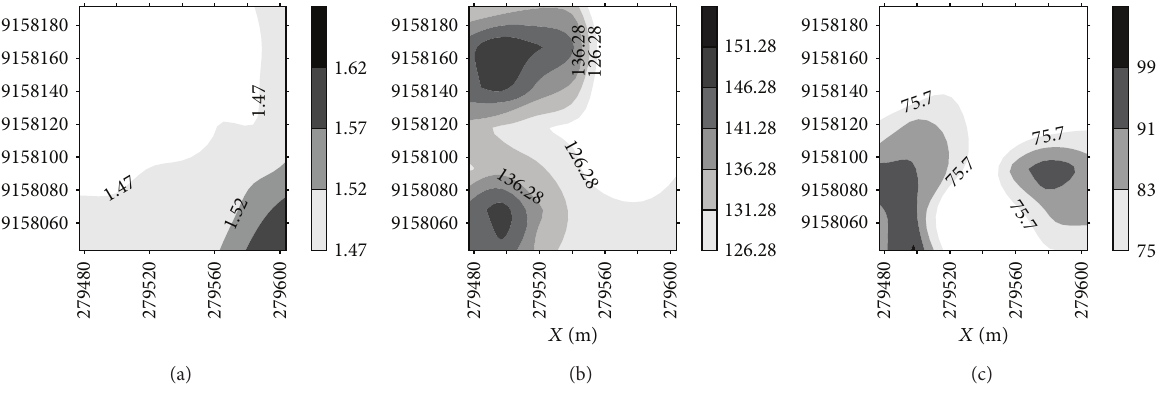
separating the areas with densities above 1.47 g cm −3 and tension above the average observed in the present